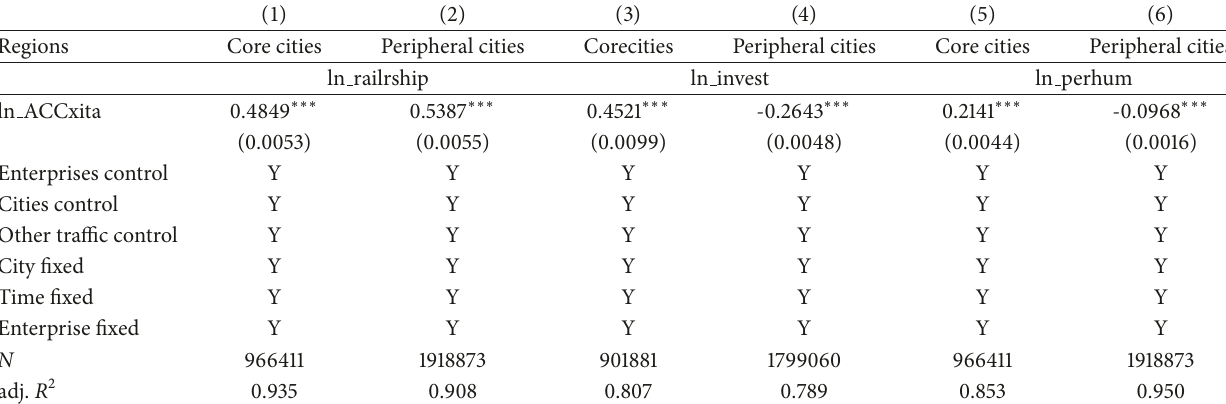
Table 10: Influence of market access on personnel flow, fixed asset investment, and human